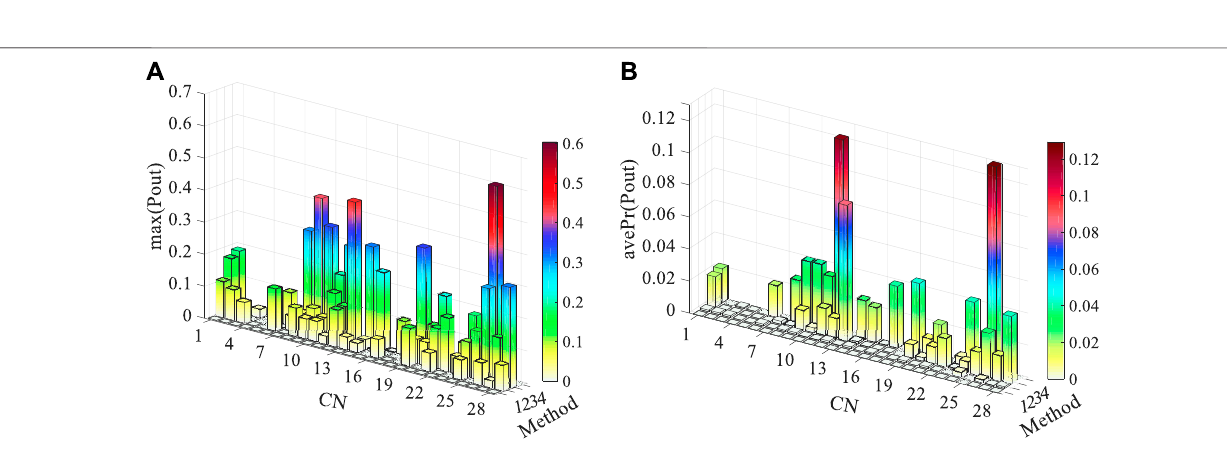
Frontiers in Energy Research |